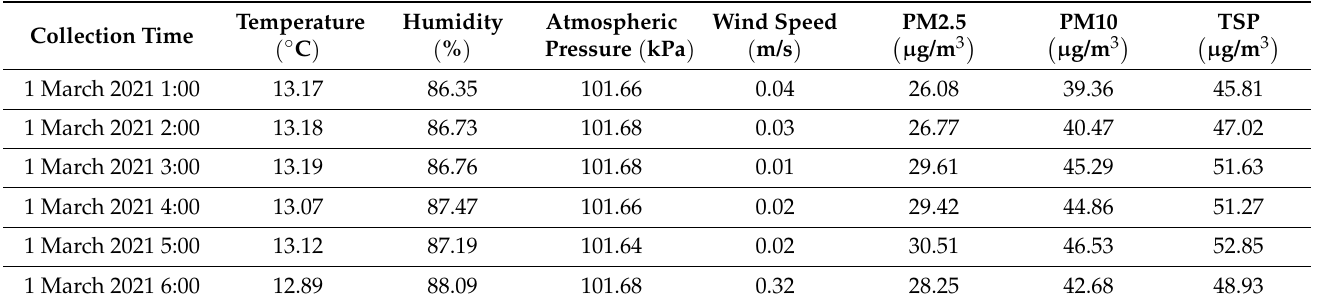
Table 7. Data collation results.